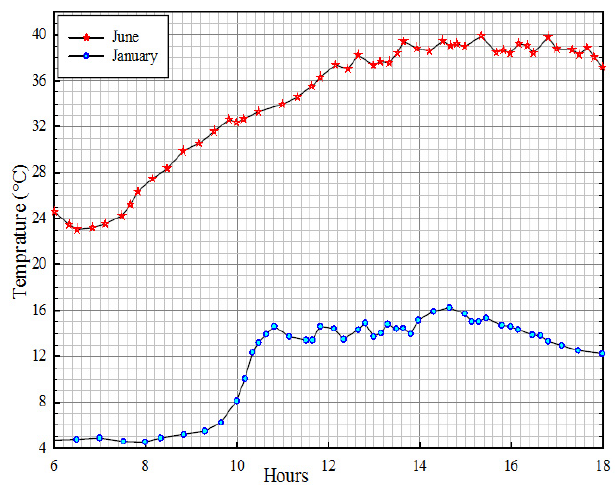
Figure 1. Variations of the temperature vs. time in January and June.